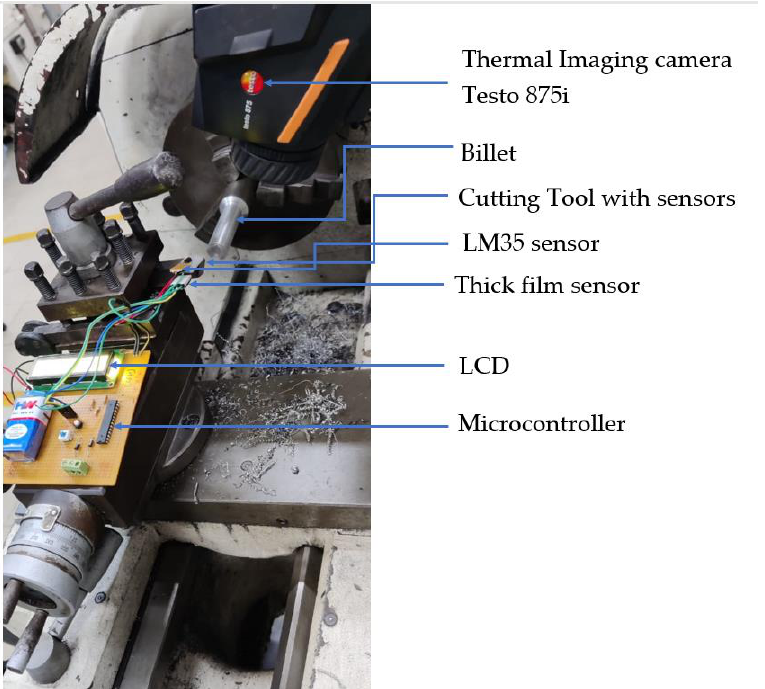
Figure 8. Cutting tool wear detection setup.